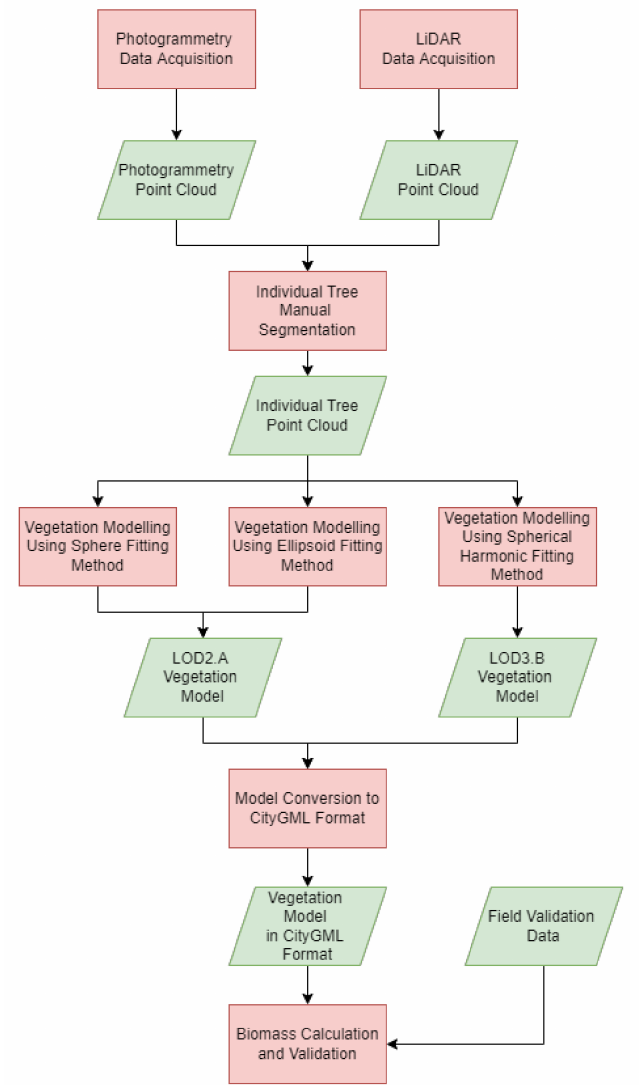
Figure 5. The flowchart of proposed